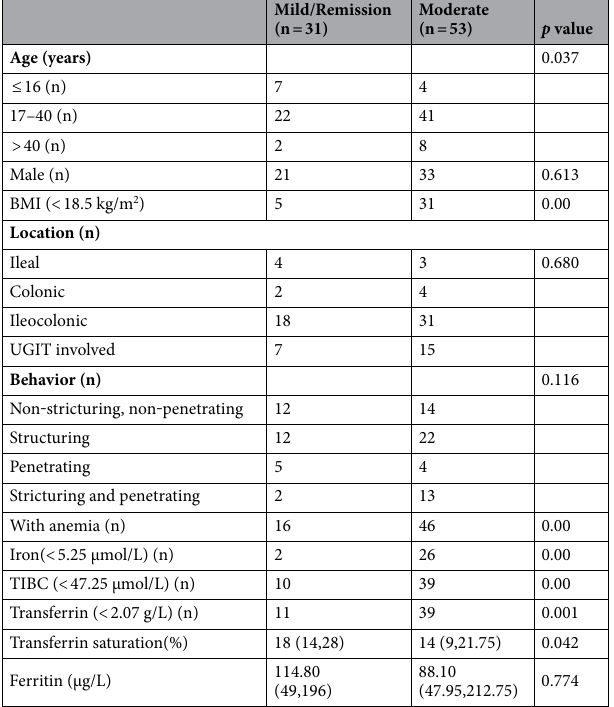
Table 4. Comparison of metrics between CD patients with different disease severities. BMI: body mass index. UGIT: upper gastrointestinal tract. TIBC: total iron binding capacity. For age, BMI, iron, TIBC and transferrin: rank-sum test. For gender distribution, location, behavior and anemia: Chi square test. For transferrin saturation and ferritin: wilcoxon rank-sum test. Only the parameters with statistical differences between groups were included in the regression